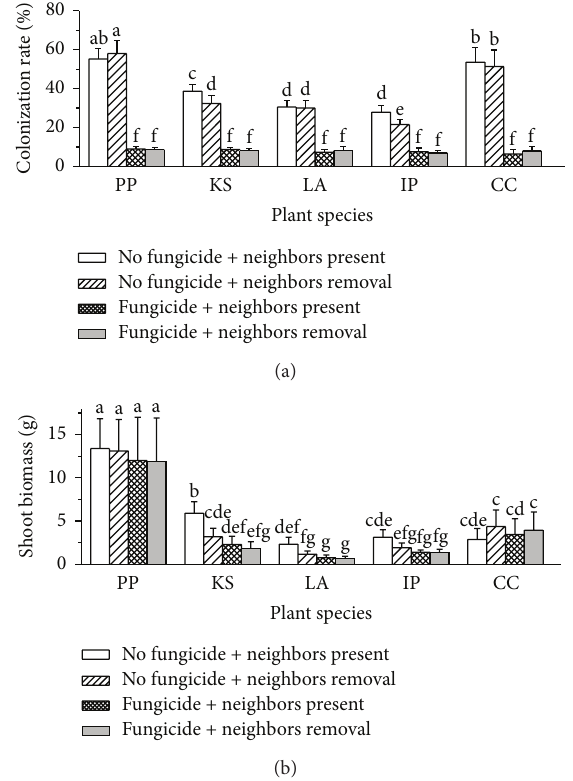
Figure 1: Arbuscular mycorrhizal colonization rate and shoot biomass of target plants under different treatments in the experi- ment. Data are means ± SD. Different letters represent significant difference among treatments. PP: Polygonum pubescens ; KS: Kum- merowia striata ; LA: Leonurus artemisia ; IP: Ixeris polycephala ; CC: Conyza